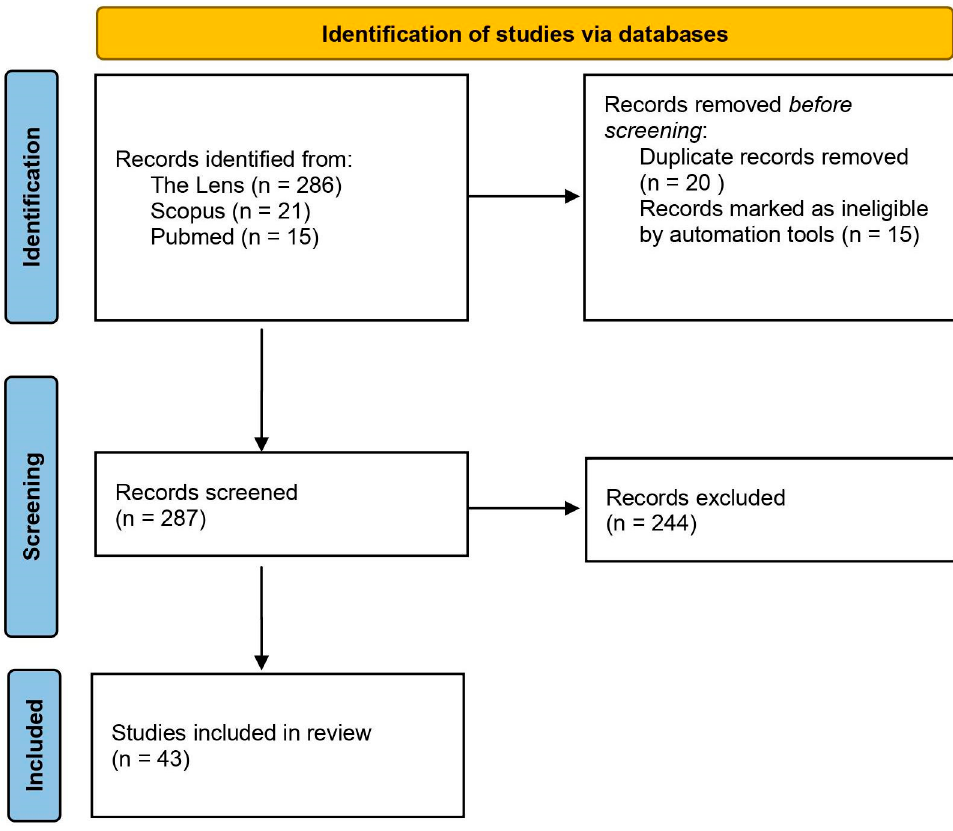
Figure 4. PRISMA flow diagram of the study.